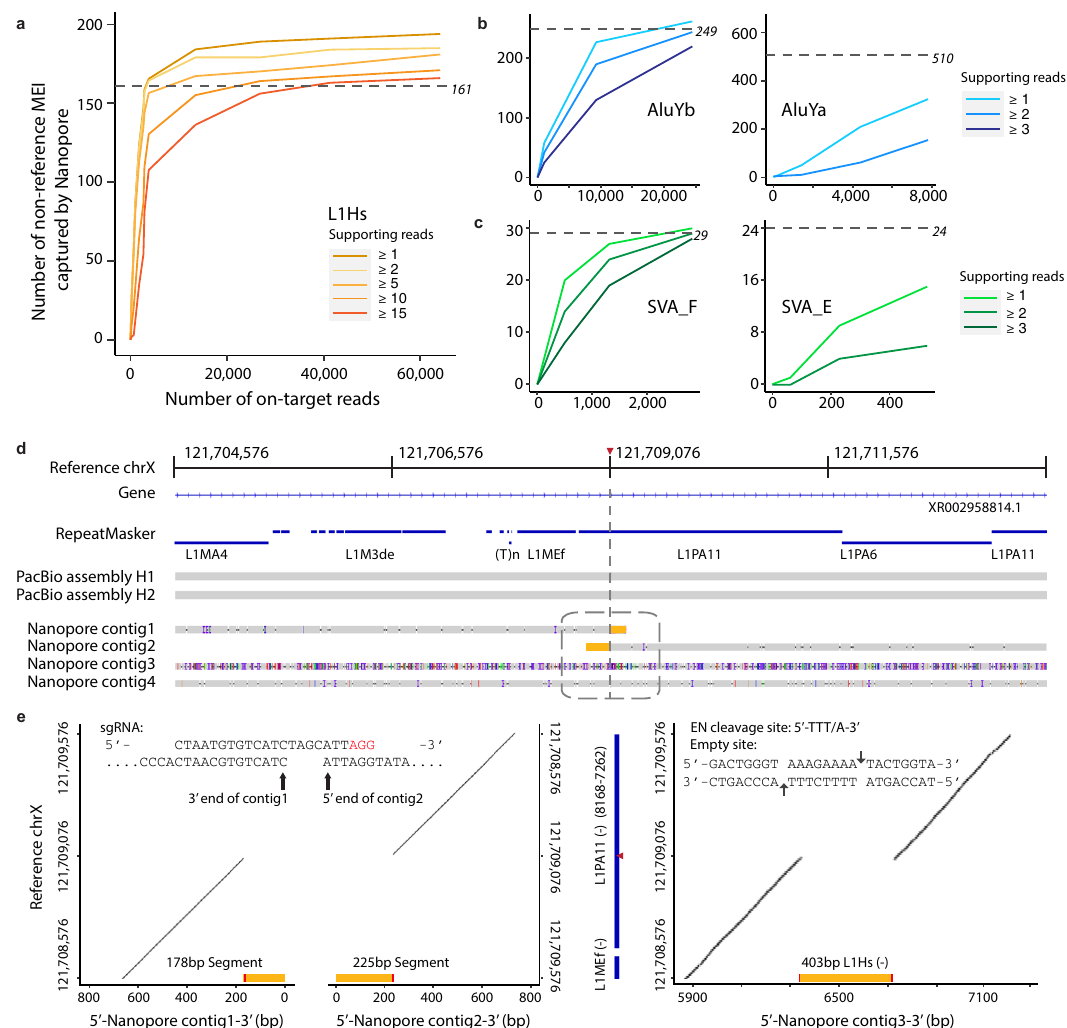
Fig. 4 Non-reference MEIs captured by nanopore Cas9 enrichment approach. a Number of non-reference L1Hs captured by nanopore Cas9 enrichment at different on-target read coverages for different supporting read cutoffs. The dotted-gray line with italic number represents the theoretical number of MEIs that the guide RNA binds when allowing a ≤ 3 bp mismatch or gap in the PacBio-MEI set. b , c Number of non-reference Alu Yb, Alu Ya, SVA_F, and SVA_E, respectively, captured by nanopore Cas9 enrichment at different on-target read coverages. Axis labels and theoretic guide number as in a . d An example of non-reference L1Hs speci fi cally captured by nanopore sequencing at chrX:121,709,076. The tracks from top to bottom are as follows: reference coordinates with a red triangle represent the insertion site, gene track, RepeatMasker track (blue bars) with reference element annotation, PacBio contigs assembly for two haplotypes, four nanopore local-assembled contigs by CANU from different classi fi cations of nanopore reads based on insertion signals (contig1, signal on 3 ′ end; contig2, signal on 5 ′ end; contig3, signal in the middle of the read; and contig4, no signal). e Recurrence (dot) plots for nanopore contigs versus the reference region chrX:121,708,576-121,7089,576 sequence. Left panel shows the most 3 ′ end of contig1 and the most 5 ′ end of contig2 versus the reference sequence. Yellow bar represents the non-reference L1Hs sequence contained in the contig. The red bar represents one side of the target site duplication motif for the non-reference L1Hs contained in the contig. The upper part of this panel demonstrates sequences at the end of two contigs regarding the cleavage site when aligning to the guide RNA sequence. Blue bars in the middle panel represent the RepeatMasker track with reference L1 information annotated, and the red triangle represents the insertion site in the reference L1 region. The right panel shows contig3 versus the reference sequence. Details of this non-reference L1Hs are detailed in the panel, including length, strand, empty site, and endonuclease (EN) cleavage site